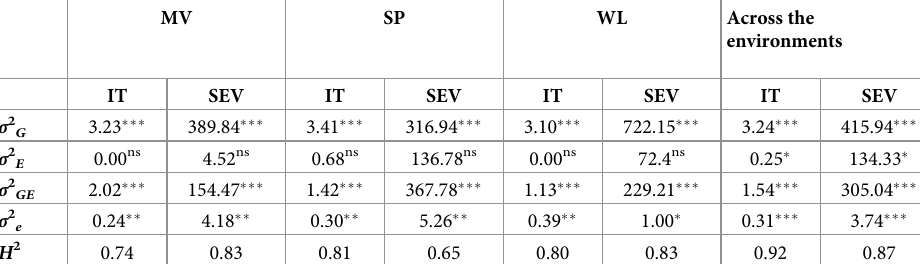
Table 2. Covariance estimates for stripe rust Infection type and disease severity and heritability for 3 locations (MV, SP, and WL) and across environments. MV